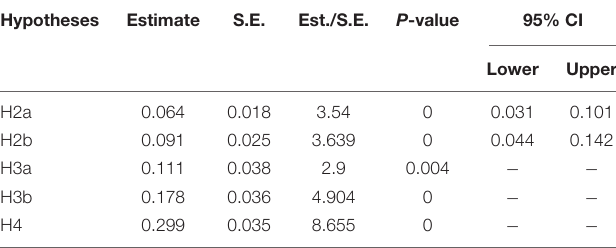
TABLE 4 | The mediating role and moderating role.